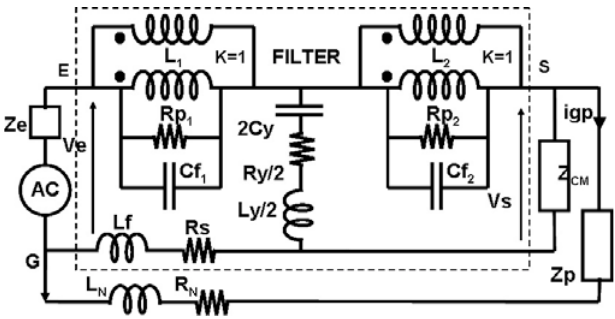
Figure 12: Measure of parasitic capacitances C